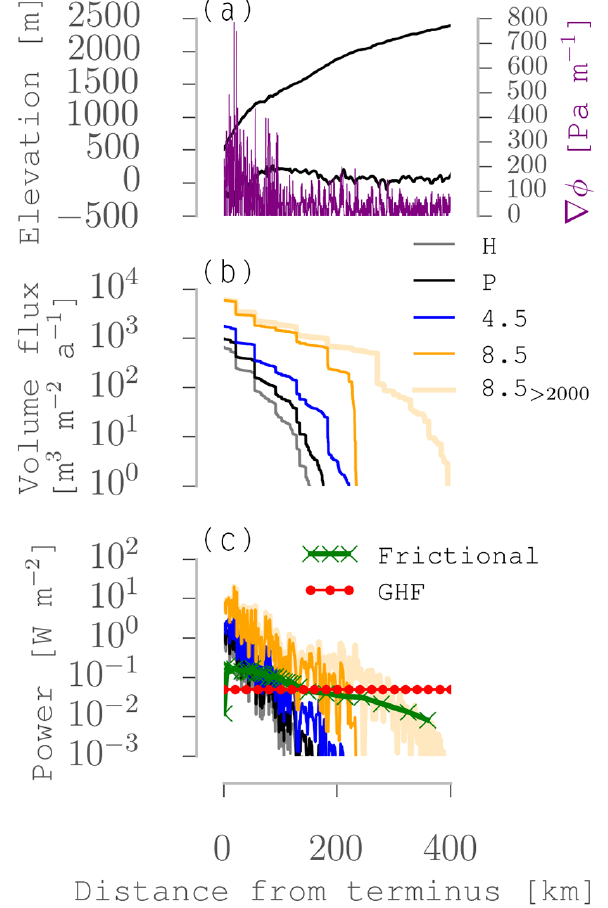
Figure 6. Detail along a flow line in southwest Greenland. (a) Sur- face and bed elevation (left axis) and gradient of φ (right axis), (b) flow rate of subglacial water, and (c) power from VHD, fric- tional heating, and geothermal heat flux (GHF). Legend labels H, P, 4.5, and 8.5 are the same as Fig. 1. Label 8.5 > 2000 represents runoff that can access the bed at elevations > 2000m surface ele- vation. Frictional heating from Brinkerhoff et al. (2011), and GHF from Shapiro and Ritzwoller (2004). Lines in (c) are smoothed to reduce visual noise and are actually as variable as (a) .